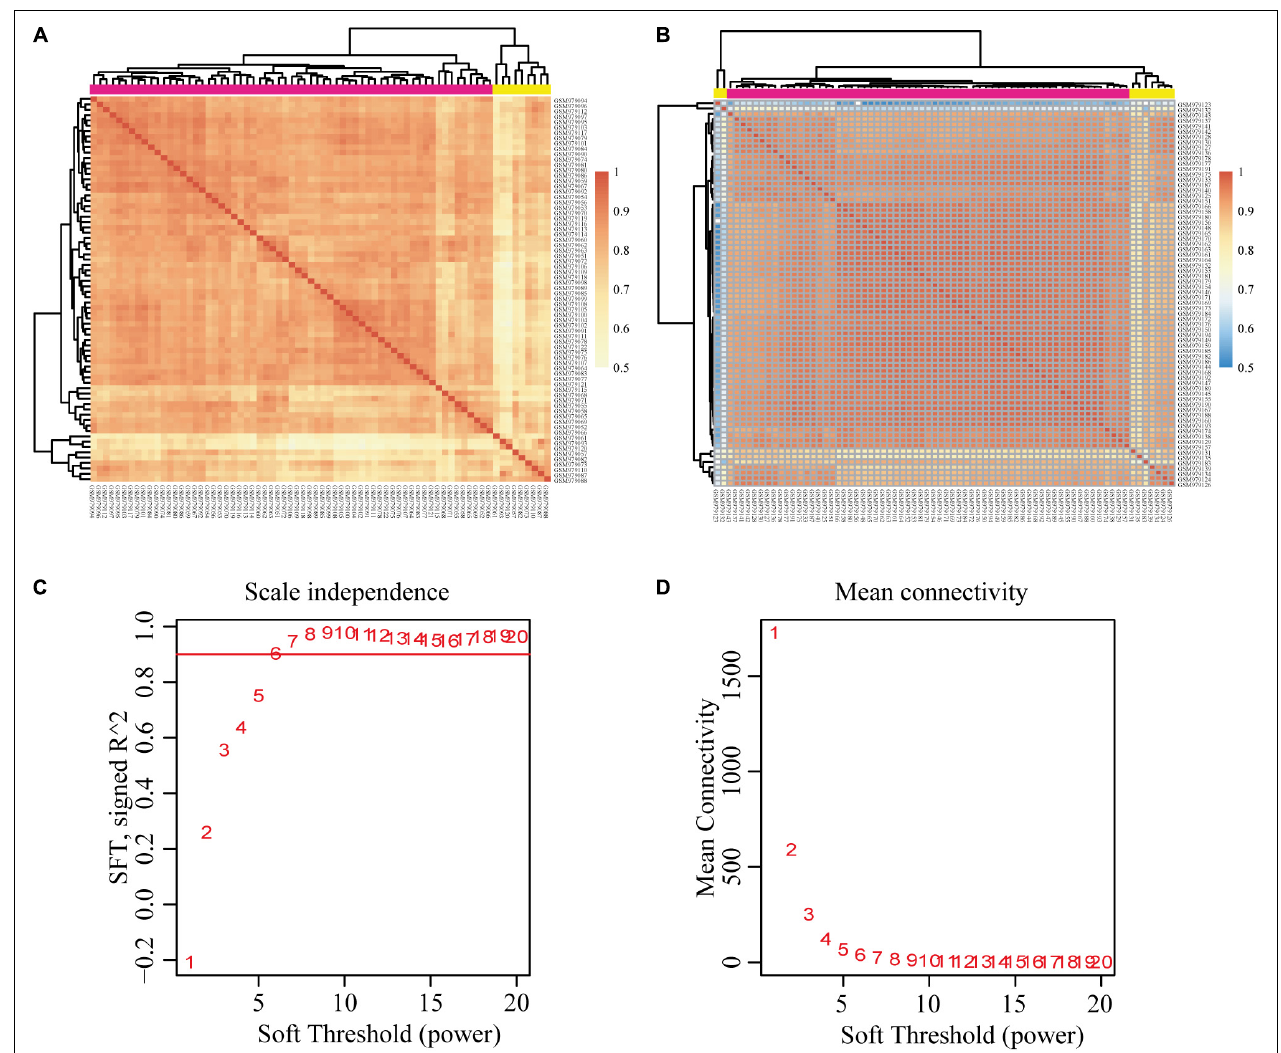
FIGURE 2 | Correlation analysis of each sample and construction of the weighted gene co-expression network based on GEO database GSE39791. (A) Correlation between HCC samples. (B) Correlation between paracancerous samples. (C,D) Analysis of network topology for various soft-thresholding powers. Pearson’s correlation test was used to assess the correlation between samples. HCC, hepatocellular carcinoma; GEO, Gene Expression